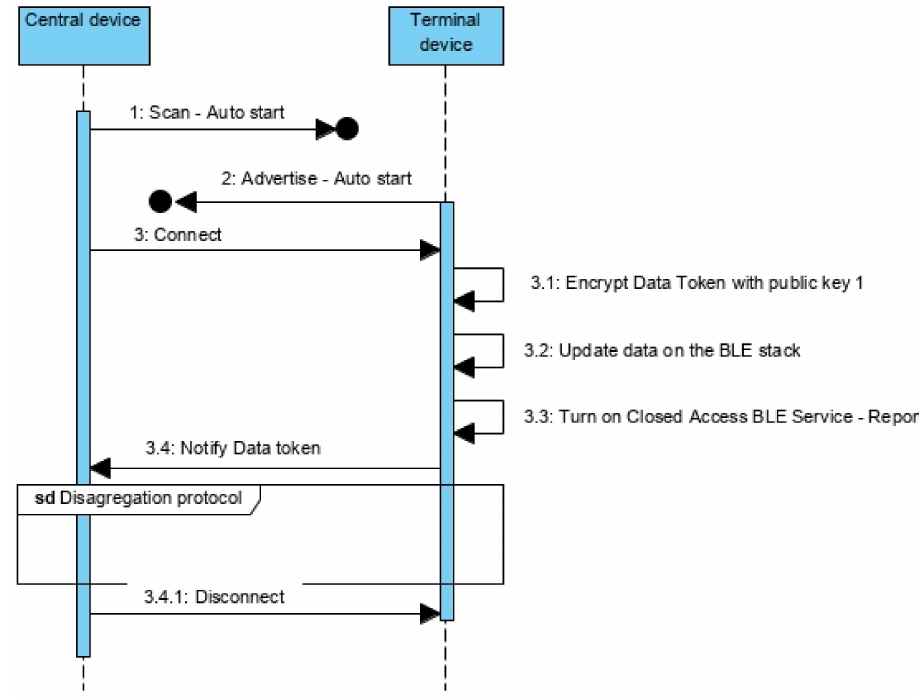
Figure 13. Report protocol for the terminal devices reports nonconformities to the